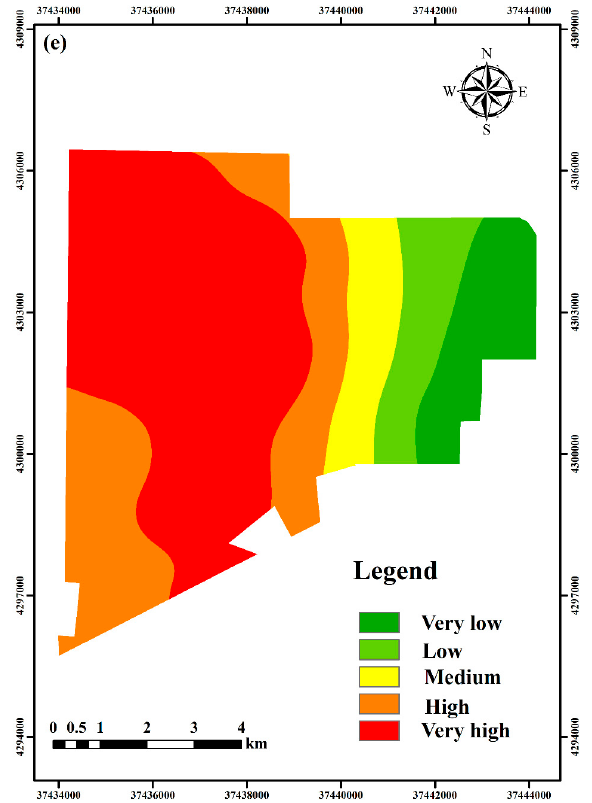
Figure 10. The evaluation result map of the roof water inrush risk under different risk attitudes: ( a ) a = 0.1; ( b ) a = 0.5; ( c ) a = 0.7; ( d ) a = 0.9; ( e ) a = 0.9.